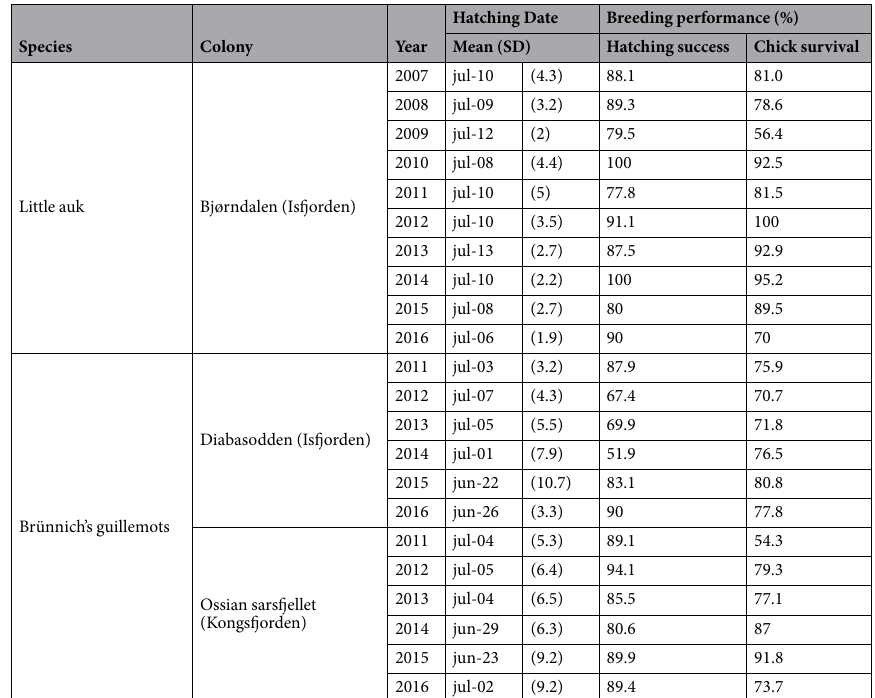
Table 1. Summary of main breeding parameters. Mean hatching date and standard deviation (SD), hatching success and chick survival at 15 days after hatching for the little auk and the Brünnich’s guillemot breeding in the Svalbard